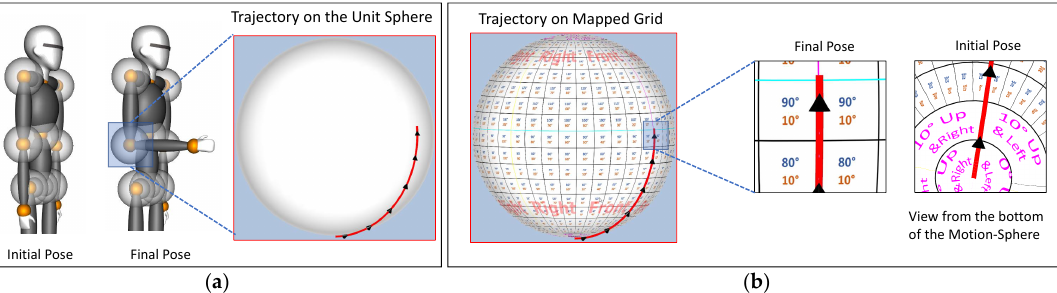
Figure 3. ( a ) A trajectory representing the lower right arm (red line) on the unit sphere. ( b ) Trajectory amounting to 90 ◦ toward the front (indicated by the labels), on a grid mapped Motion-sphere.